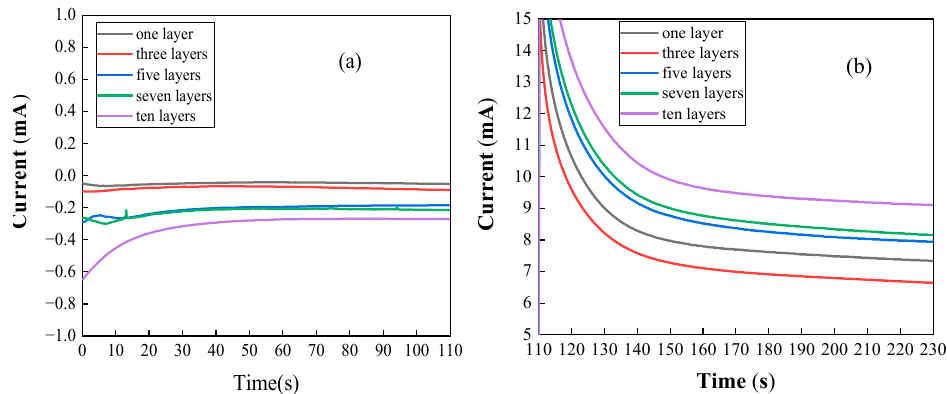
Figure 3. ( a ) I-t curve of Cu-TiO 2 photoelectrode in the Fe 2+ and Cr 3+ electrolytes under 0 V bias; ( b ) I-t curve of Cu-TiO 2 photoelectrode in the Fe 2+ and Cr 3+ electrolytes under 0.5 V bias.